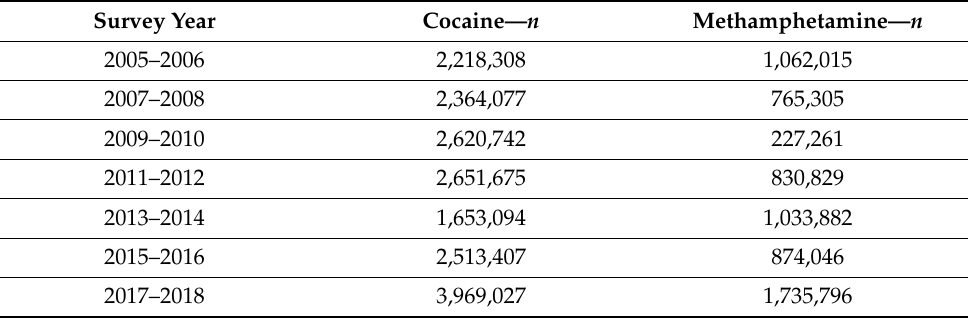
Figure 1. Estimated prevalence of past-month cocaine and methamphetamine use by survey years, NHANES 2005–2018. Prevalence is represented as the percentage of the U.S. population reporting using cocaine or methamphetamine in the past month. Values on the graphs represent percent change compared to the previous survey year, with values in green indicating an increase and values in red indicating a decrease compared to the previous cycle. Table 1. Estimated frequencies of past-month cocaine and methamphetamine use by survey years, NHANES 2005–2018. Frequencies were extrapolated to the U.S. population using weights provided by NHANES for each cycle between